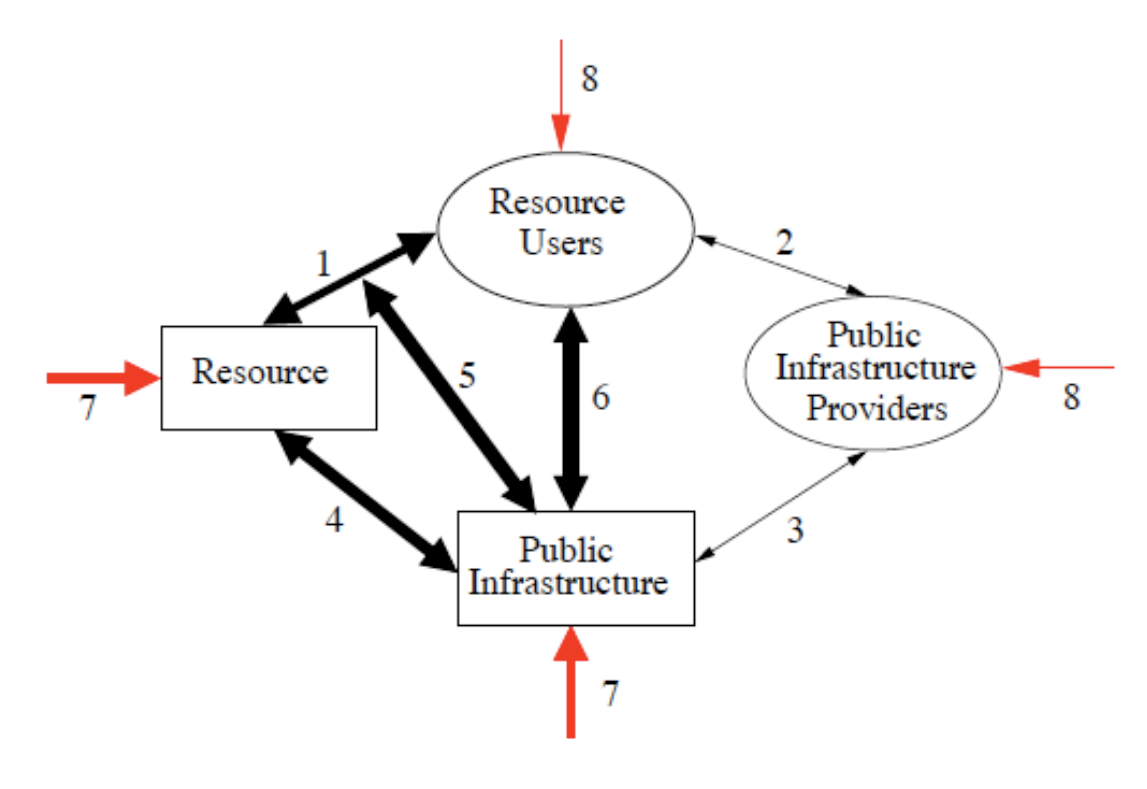
Fig. 13 . Robustness diagram for the Pumpa irrigation system modified based on the analysis of the model. Line thickness refers to the relative importance of a given interaction. Numbers are for cross- referencing descriptions of each interaction (see